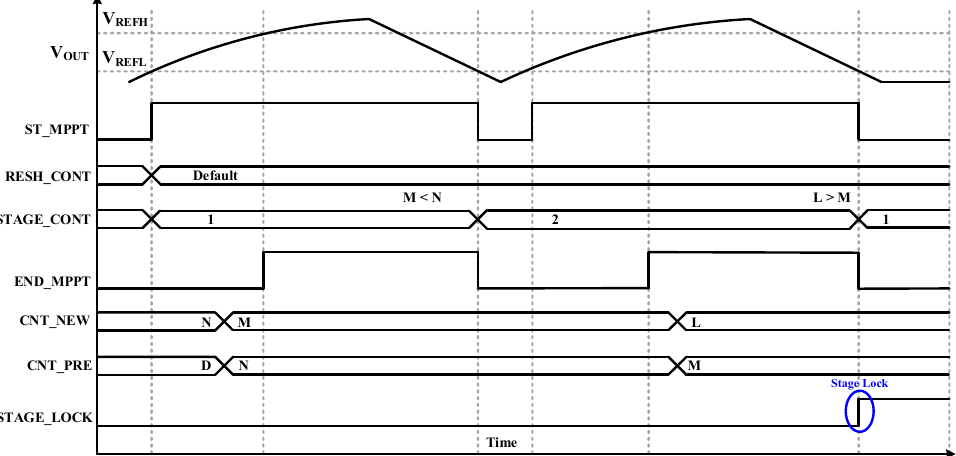
Figure 6. Timing diagram of Maximum Power Point Tracking (MPPT).